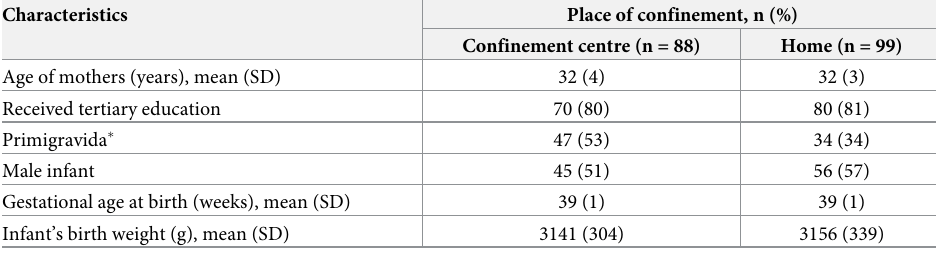
Table 1. Demographic characteristics of the mothers and infants (n = 187).